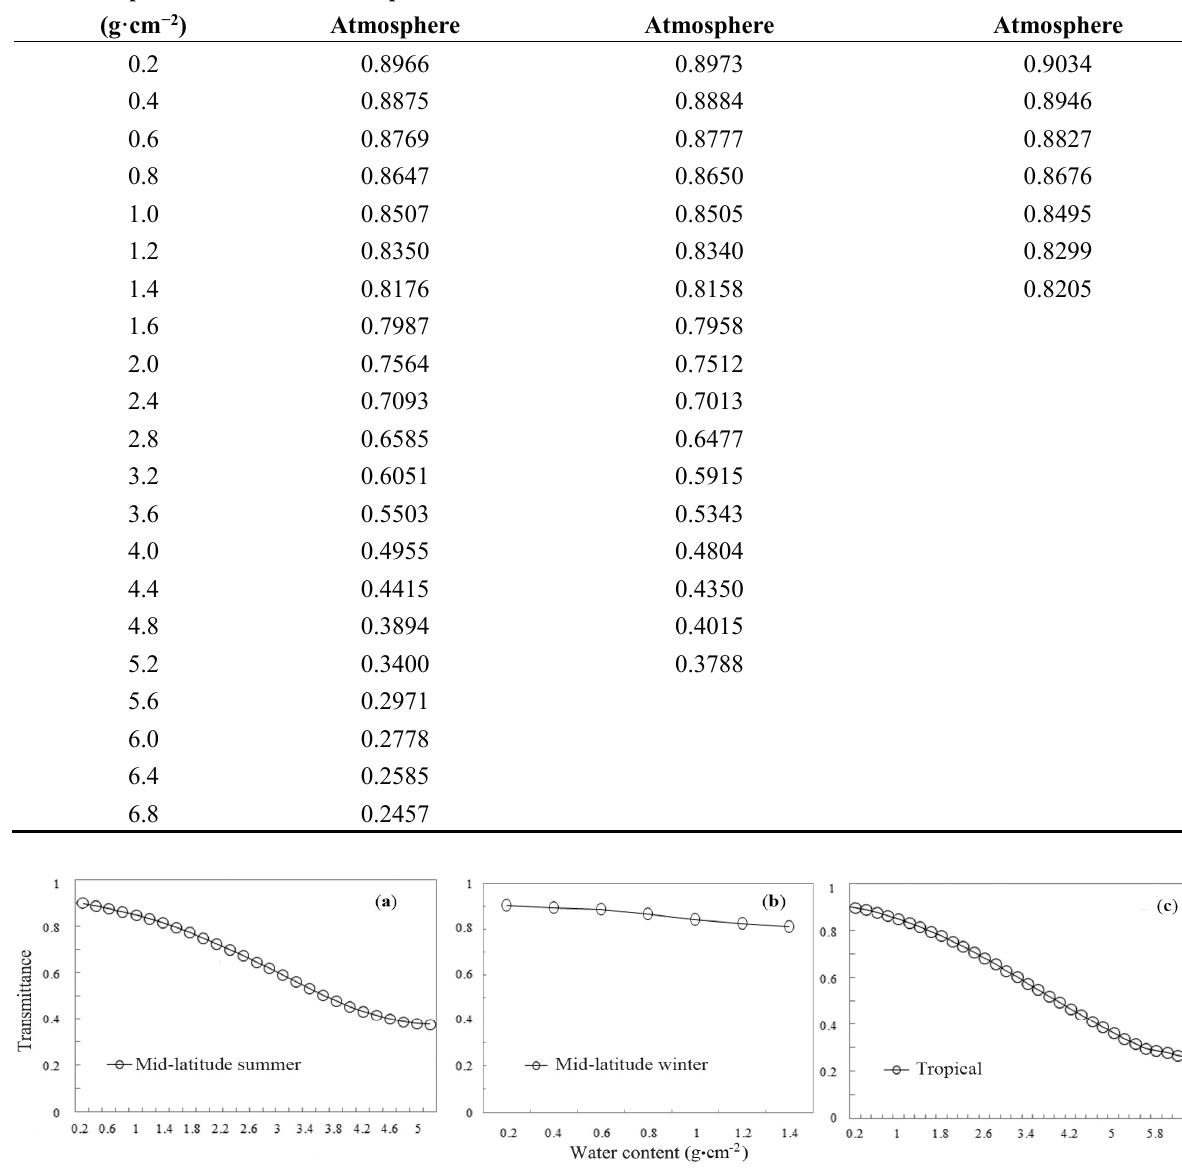
Figure 2. Change of atmospheric transmittance with water vapor content for Band 10 of Landsat 8 under various atmospheres: ( a ) mid-latitude summer; ( b ) mid-latitude winter; and ( c )